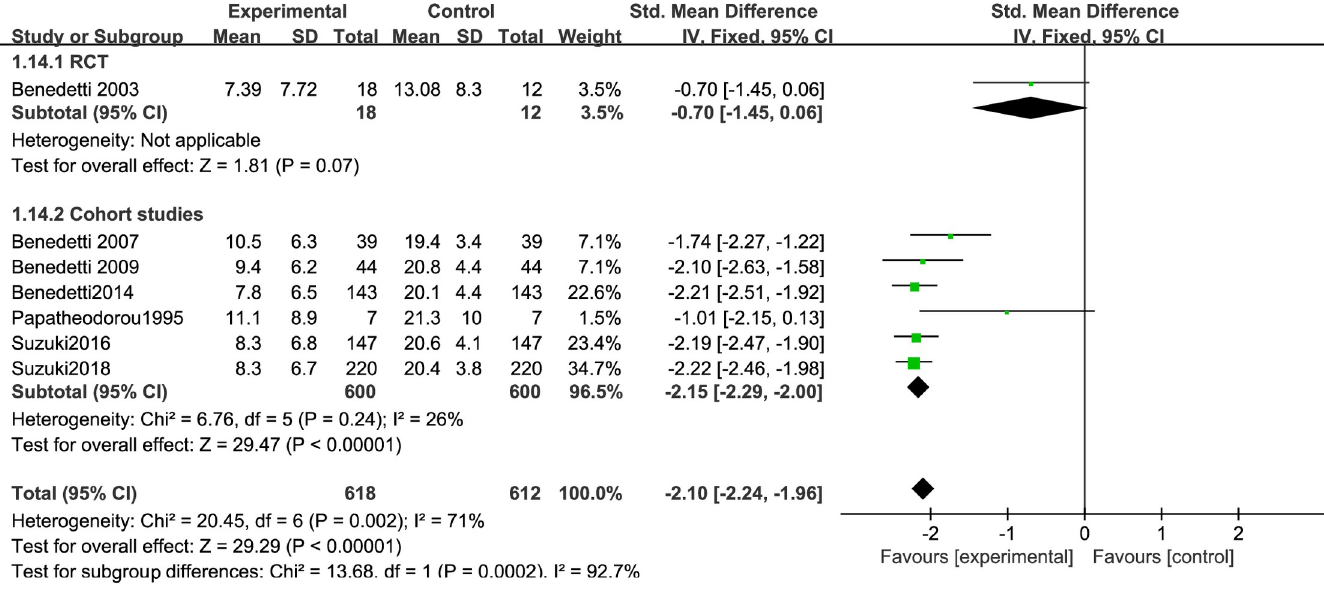
Fig 6. Forest plots for morning plus night phototherapy.